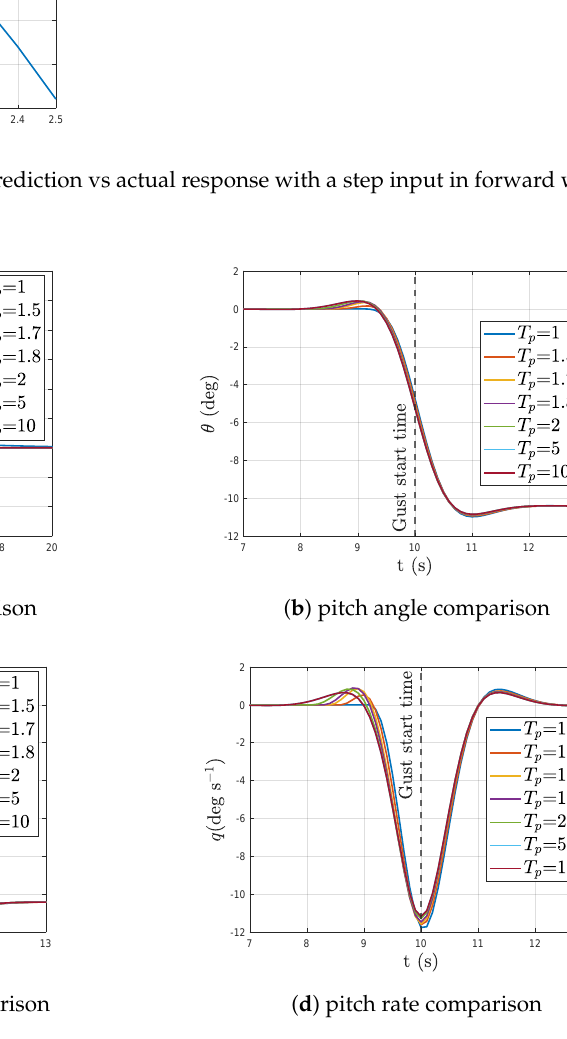
Figure 7. Linear aircraft response with varying wind preview lengths to a step input in forward wind of 10 ms − 1 at time t = 10